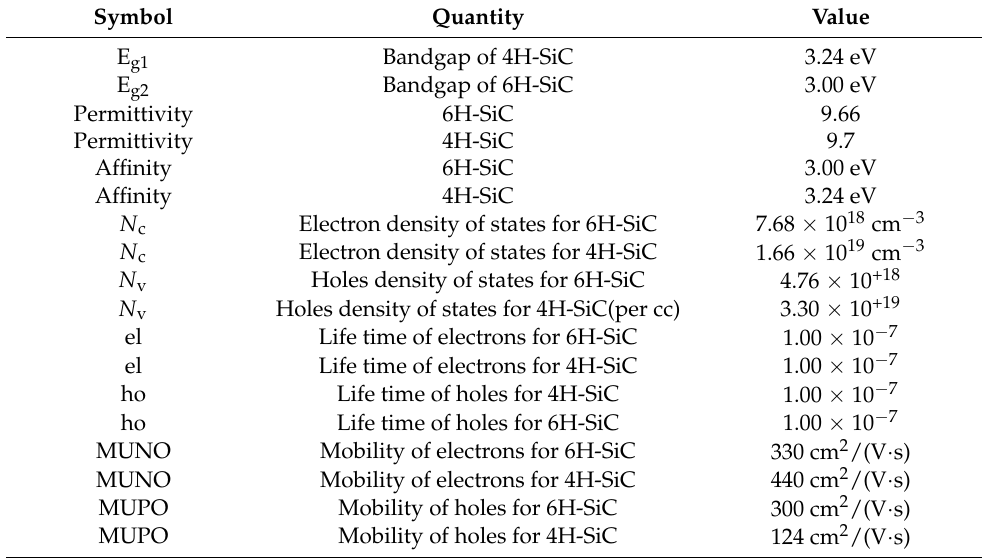
Table 1. Materials parameters used in SILVACO TCAD for simulated SiC LED [47]. Symbol Quantity Value E